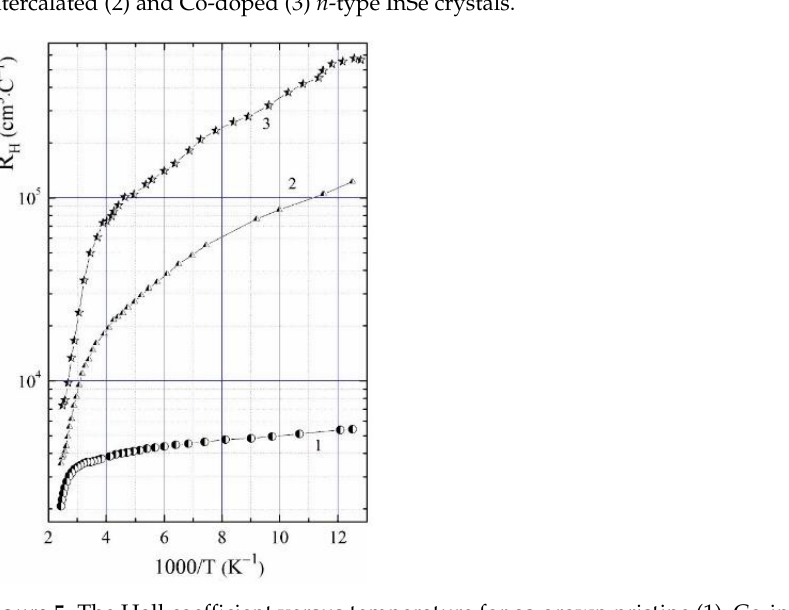
Figure 4. The in-plane electrical conductivity versus temperature for as-grown pristine (1), Co-intercalated (2) and Co-doped (3) n -type InSe crystals.